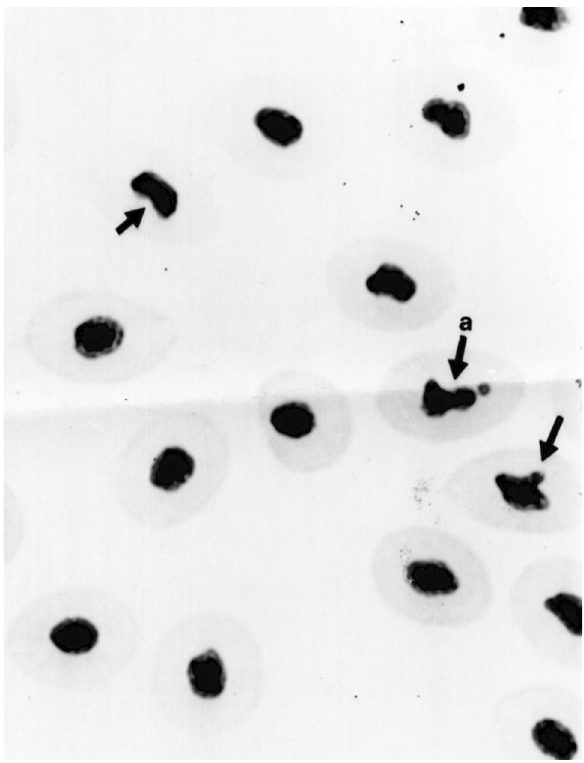
Figure 1 - Photomicrograph (1000 X) of a kidney blood smear from T. rendalli treated with cyclophosphamide, showing a deformed and micro- nucleated erythrocyte nucleus (a), and two other erythrocytes with de- formed nuclei